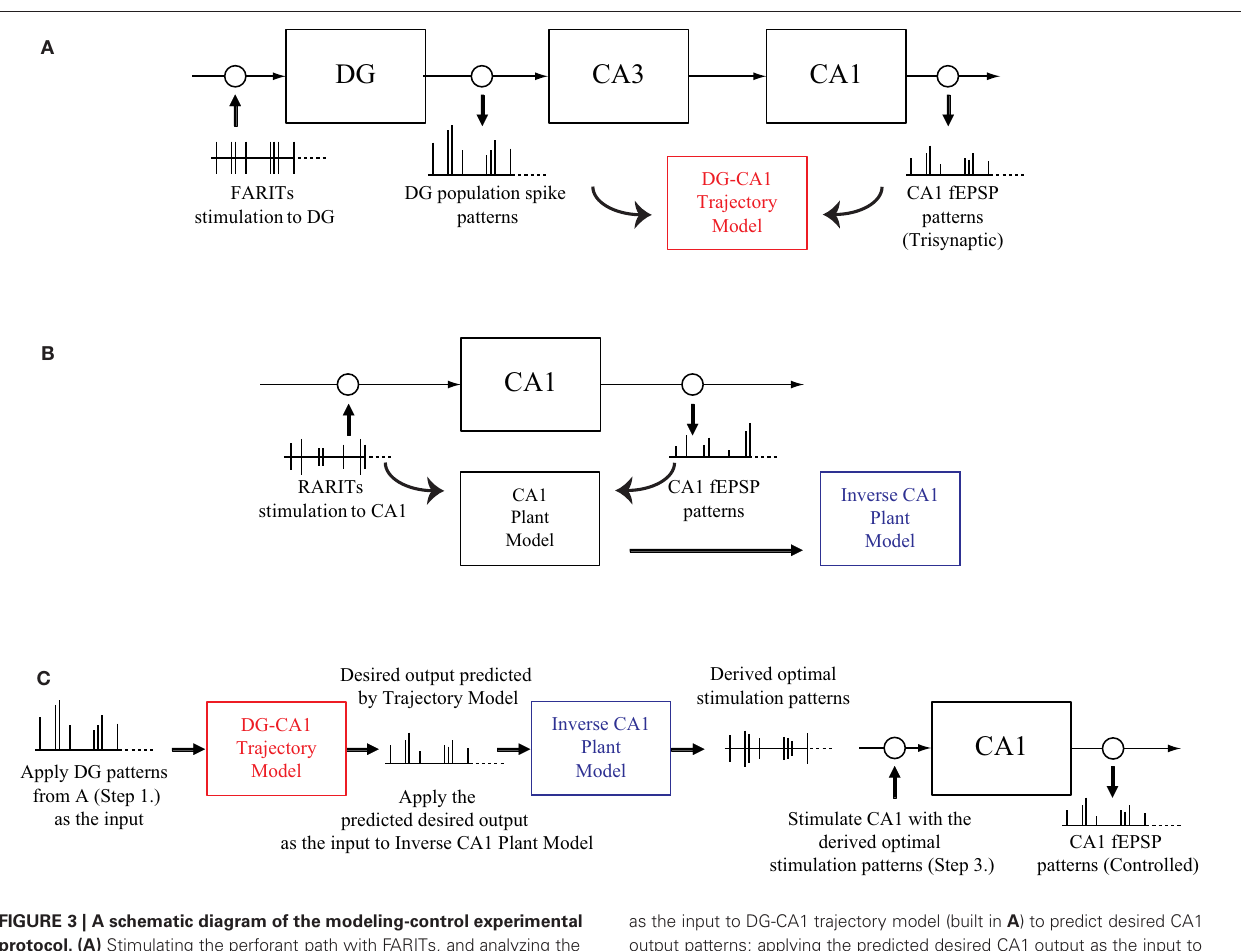
FIGURE 3 | A schematic diagram of the modeling-control experimental protocol. (A) Stimulating the perforant path with FARITs, and analyzing the trisynaptic responses in DG and CA1, to build a DG-CA1 trajectory model. (B) Stimulating the Schaffer collaterals with RARITs, and analyzing the monosynaptic responses in CA1, to build a CA1 plant model. The inverse CA1 plant model can then be formulated. (C) Applying DG patterns (from A )